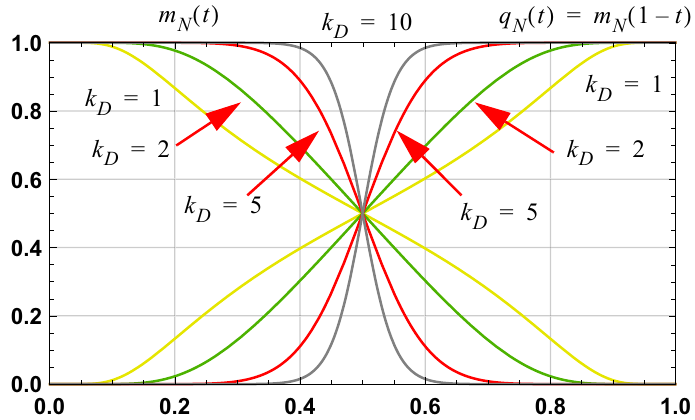
Figure 2. Graph of the normalized demarcation functions m N ( t ) and q N ( t ) as defined by (16). Such functions are infinitely di ff erentiable on (0, 1), and have right and left hand derivatives, of all orders, that are zero, respectively, at the points of zero and one.